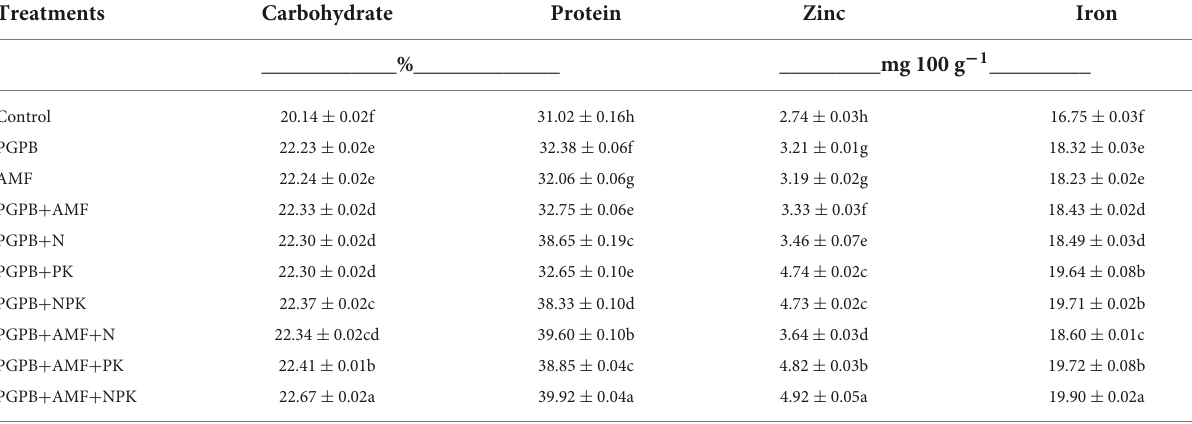
TABLE 3 Nutrient contents of soybean grains as affected by inoculation of plant growth-promoting bacteria (PGPB) and arbuscular mycorrhiza fungi (AMF), with or without the addition of nitrogen (N), phosphorus (P), and potassium (K) fertilizers. Treatments